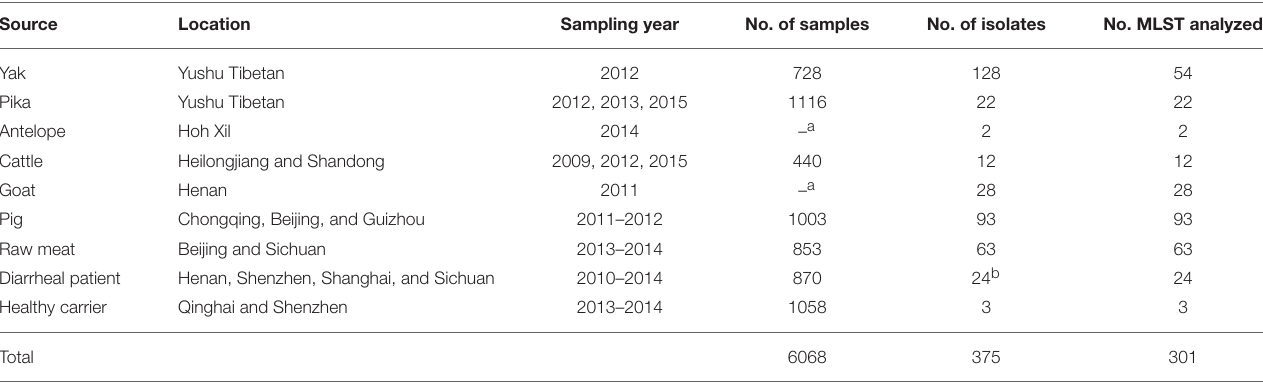
TABLE 1 | Non-O157 STEC isolates used in this study and origin of isolation.